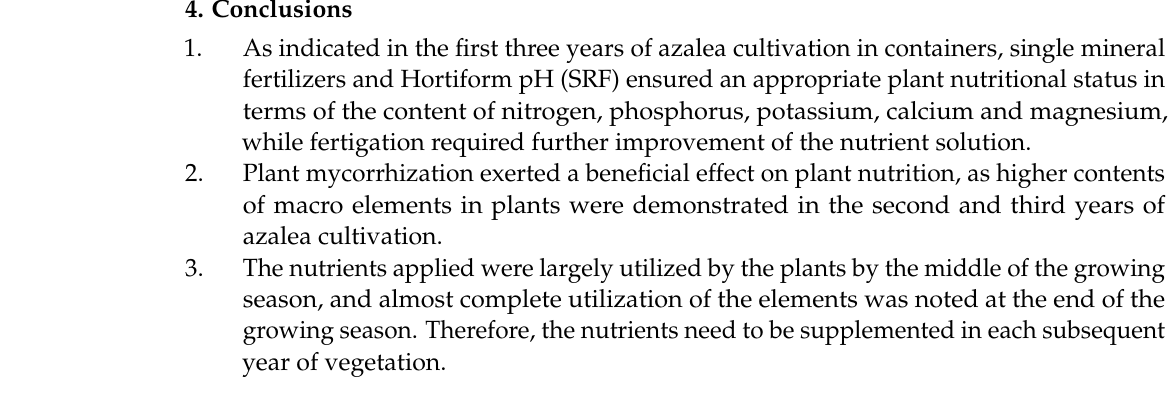
Mycorrhizae (A) Type of Fertilization (B) Without ERM (M-)